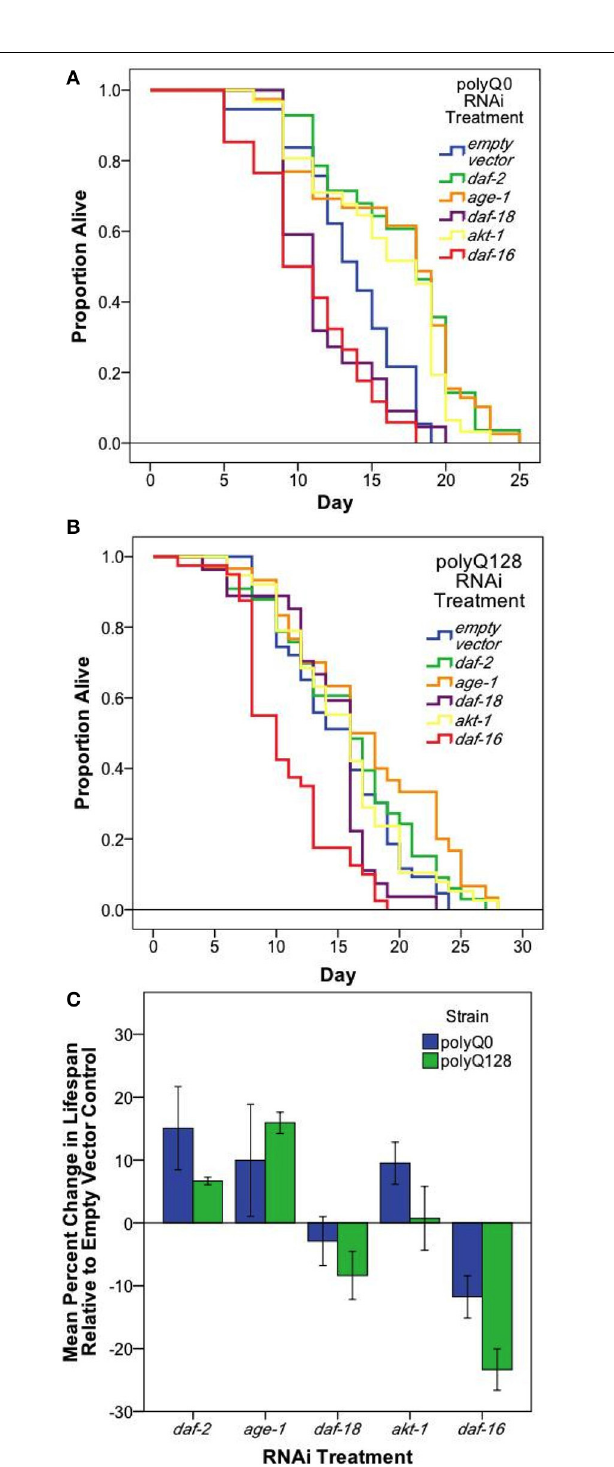
FIGURE 3 | Neuronal and systemic insulin signaling mediates lifespan of both healthy (polyQ0) and proteotoxically stressed (polyQ128) animals. Kaplan–Meier survival curves for one representative survival experiment shown for polyQ0 (A) and polyQ128 (B) animals with RNAi knockdown of the indicated insulin signaling pathway gene. Mean lifespan, sample size, and significance reported as Replicate 1 for each strain